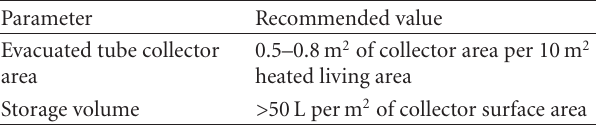
Table 4: Design guidelines for solar thermal spatial heating system.